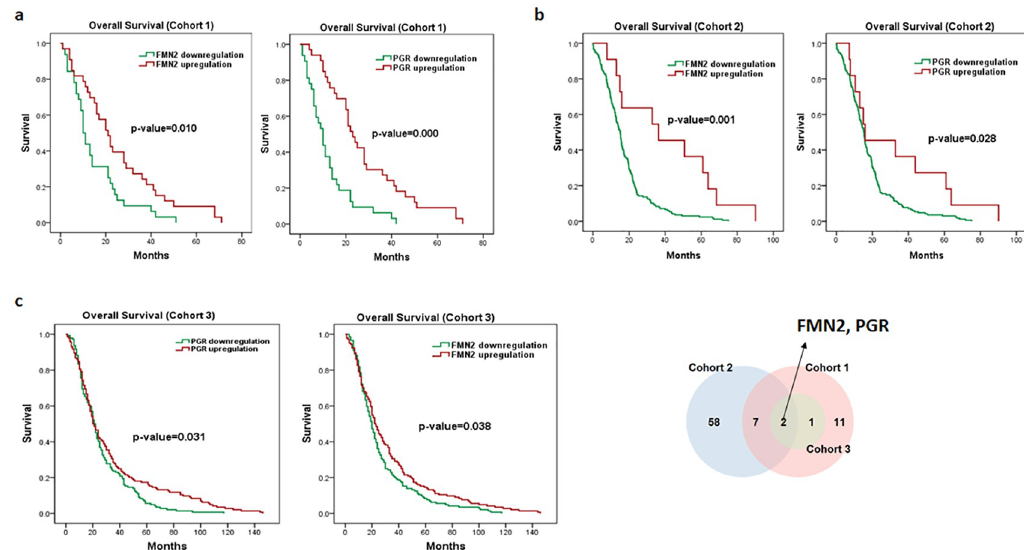
Fig 4. Kaplan–Meier survival analyses of FMN2 and PGR (top common genes of FGF14 ) in PDAC cohorts 1, 2 and 3. Red represents expression � the median, while green represents expression < the median. Overall survival plots of FMN2 , PGR ( a ) in cohort 1. Overall survival plots of FMN2 , PGR ( b ) in cohort 2. Overall survival plots of FMN2 , PGR ( c ) in cohort 3. ( � p � 0.05).